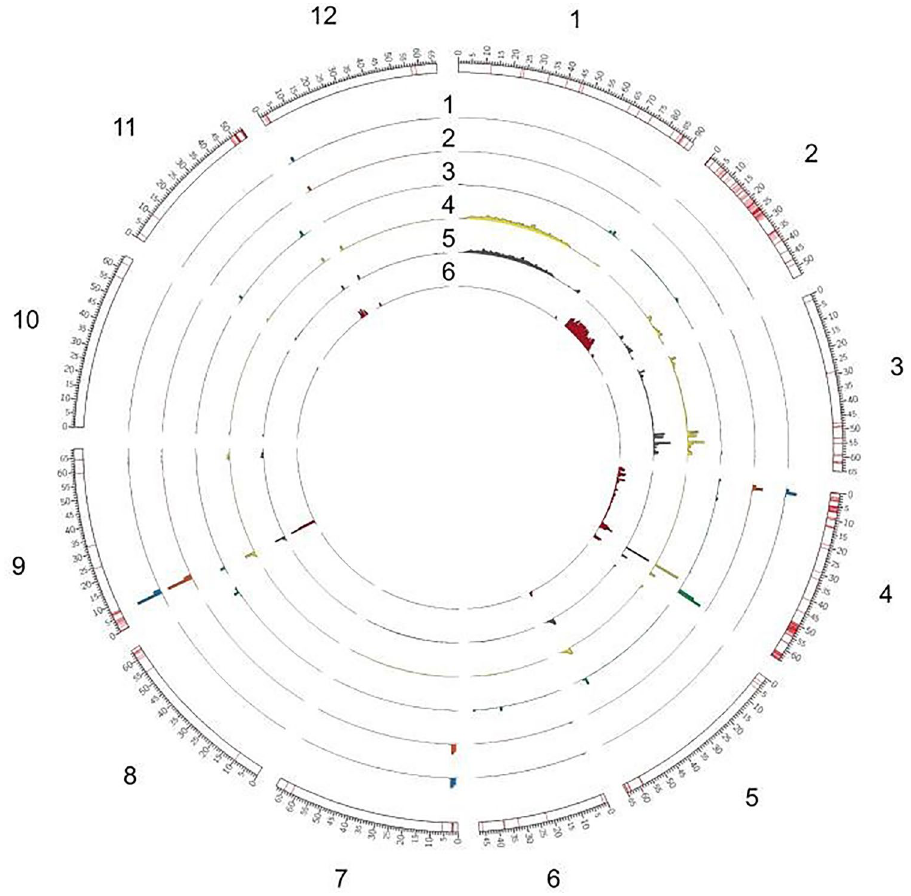
Figure 4. The genome-wide distribution of filtered variants and highly-affected genes of six bacterial wilt ( Ralstonia sp.) resistant tomato lines. The 12 chromosomes are numbered clockwise, and the red bands on the outermost bars are genes highly affected by polymorphisms of 6 resistant accessions. The six histograms display the number of SNPs in 1-mb windows of 6 resistant tomato accessions. The lines are numbers (1) Hawaii 7996, (2) Hawaii 7997, (3) LE415, (4) F7_80P, (5) F7_80465P, and (6)